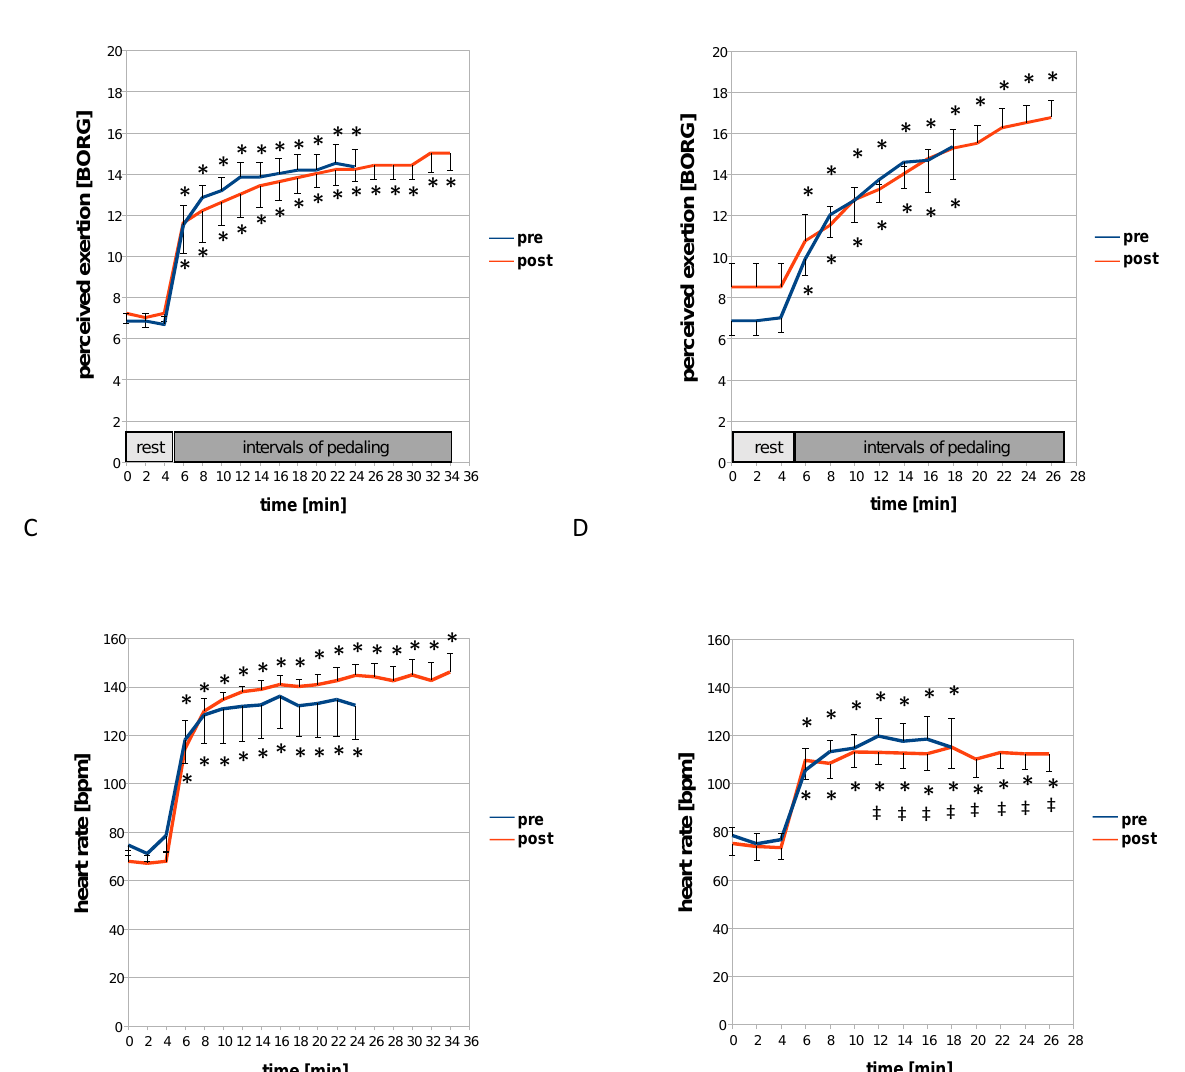
Figure 2. Temporal response of perceived exertion and heart rate during concentric and eccentric type of interval exercise. Line graph with whiskers indicating mean values ± SE for perceived exertion ( A , B ) and heart rate ( C , D ) as measured each 2 min during the interval-type pedaling exercise before and after the eight weeks of training of the two groups under the concentric ( A , C ) or eccentric ( B , D ) contraction protocol. The rest and pedaling phase of the respective concentric and eccentric interval exercise is exemplarily indicated in panels A and B. *, p < 0.05 vs. 0 min. ‡, p < 0.05 vs. concentric. Repeated-measures ANOVA with a post-hoc test of least significant